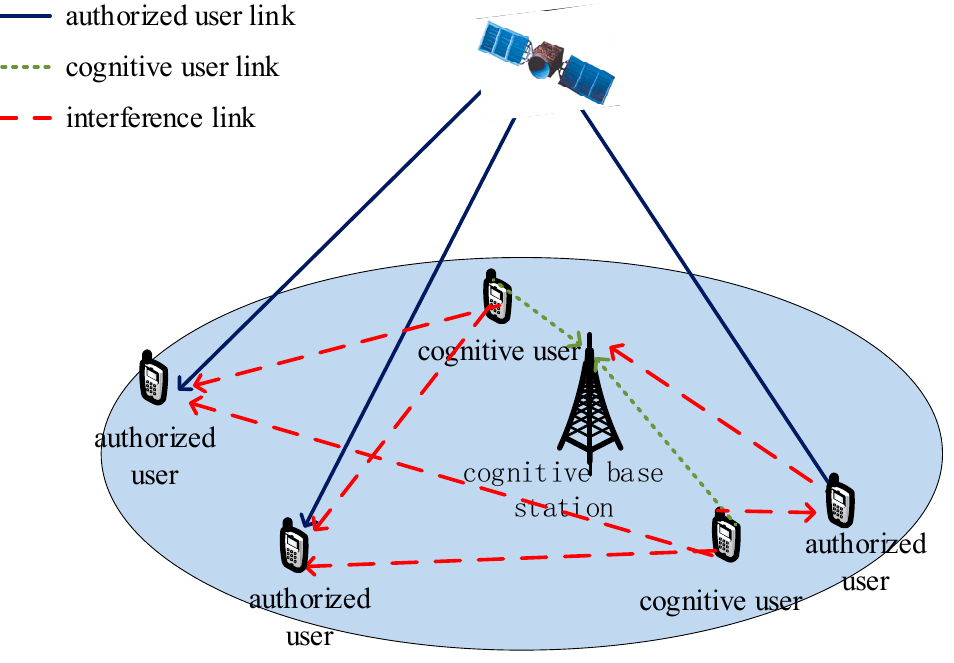
Figure 1. Spectrum sharing for integrated satellite terrestrial networks.